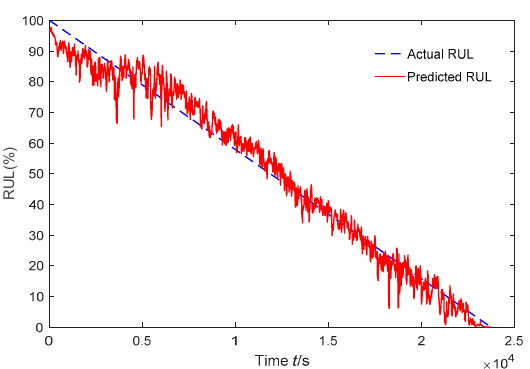
Figure 12. RUL prediction result of bearing 1_3 using the proposed method.